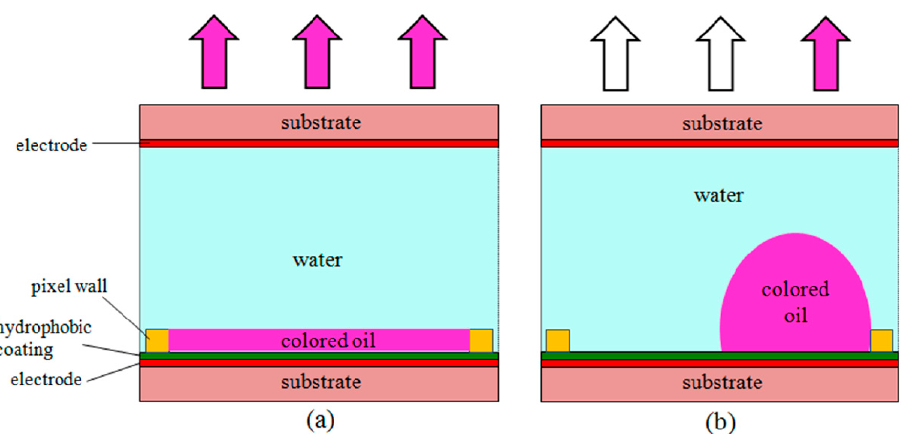
Figure 5. Schematic illustration of the electrofluidic display (EFD) principle. ( a ) In an EFD pixel, without applied voltage, a homogeneous oil film spreads over the pixel area, exhibiting the color of the dyed oil; ( b ) Under applied voltage, the oil film contracts to a corner of the pixel, exposing the color of the underlying substrate.